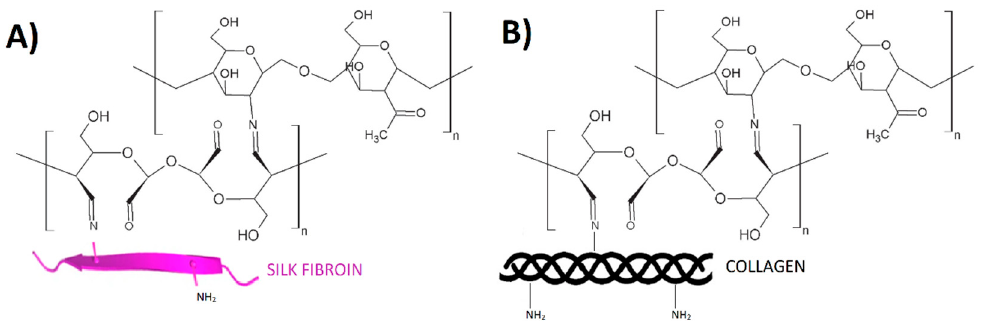
Figure 5. The possible mechanisms of cross-linking between chitosan, a compound with a dialdehyde group (e.g., DAS, DAC) and ( A ) silk fibroin or ( B ) collagen.